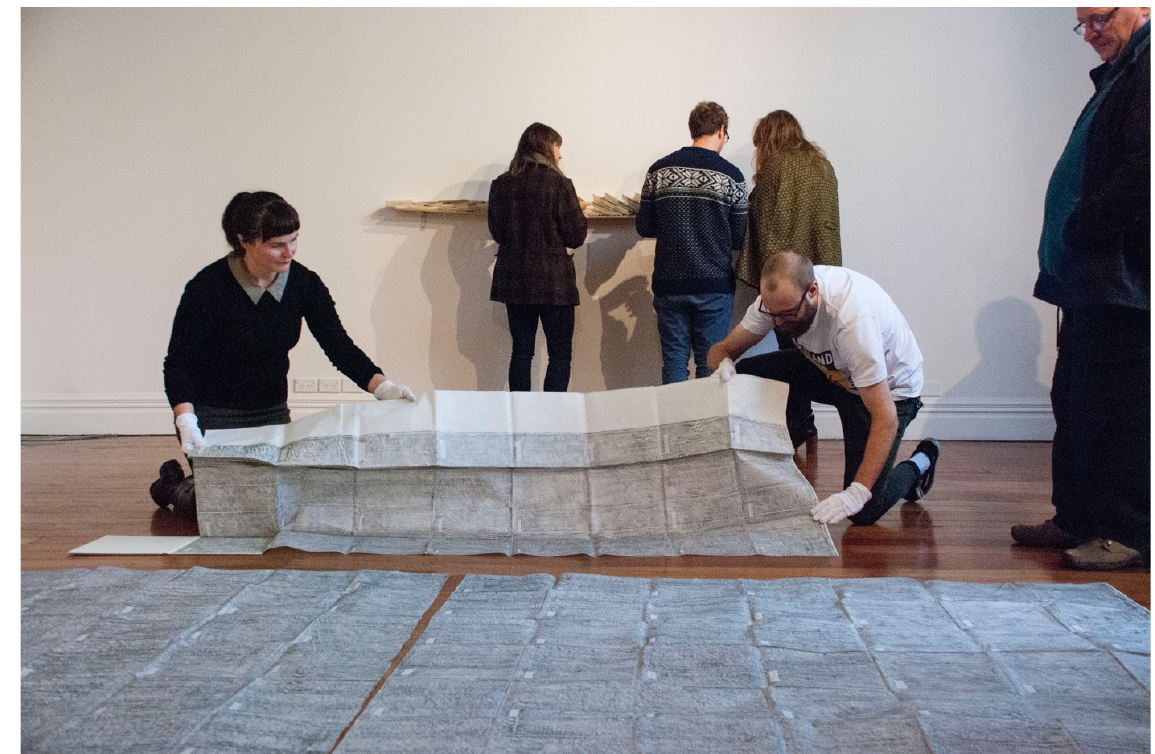
Figure 6. The floor we walk on , 2015. Enjoy Public Art Gallery, Te Whanganui-a-tara. One-off public performance for the exhibition Something Felt, Something Shared (curated by Emma Ng). Graphite on paper, dimensions variable. Photo: Louise Rutledge. Collection of Chris Parkin.